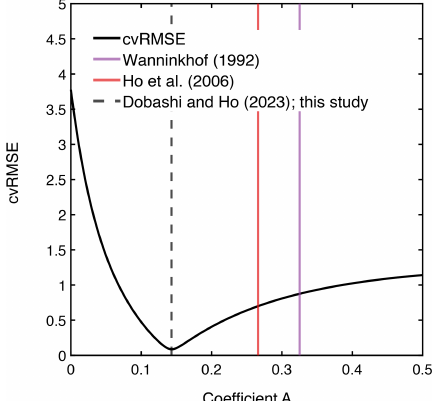
Figure 4. The relationship between cvRMSE and the coefficient A in the equation k (600) = Au 2 . Three vertical lines indicate the co- 10 efficients derived from this study, as well as those of Ho et al. (2006) and Wanninkhof (1992) from left to right. Note that k (660) in Wan- ninkhof (1992) was converted to k (600) by assuming that they are scaled as Sc to the power of − 1 /